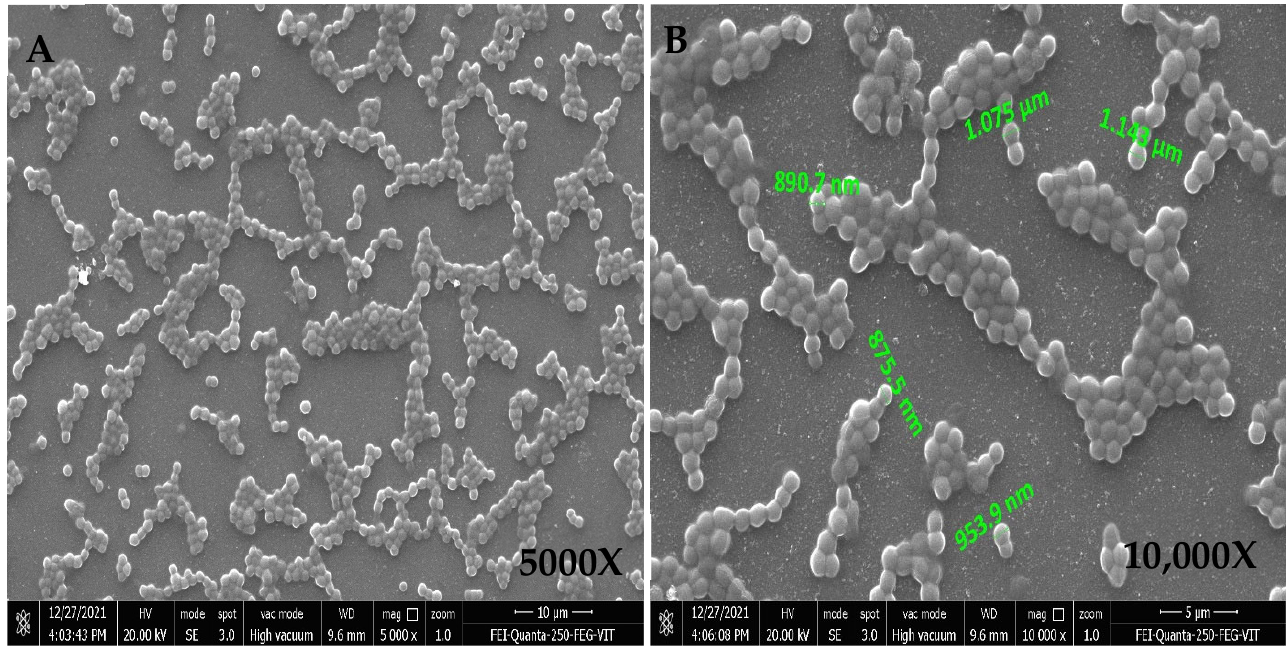
Figure 2. Scanning electron microscope images under 5000X ( A ) and 10,000X ( B ). Cocci in clusters.